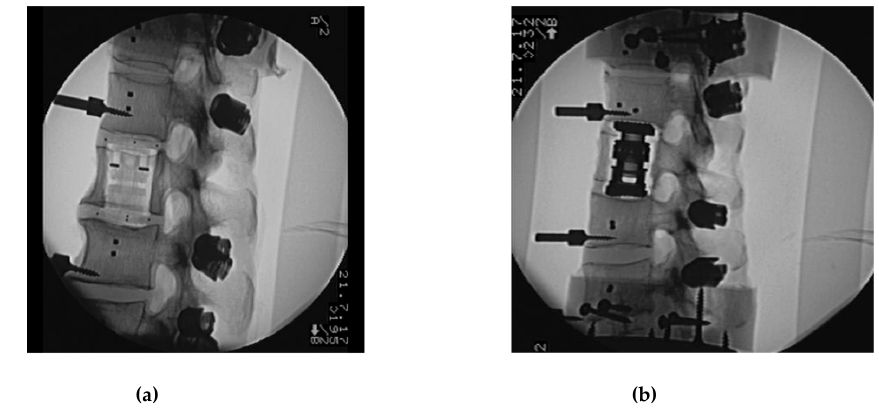
Figure 4. Lateral view native radiographs documenting correct positioning of the ( a ) prototype non-metallic, X-ray-translucent CF / PEEK expandable vertebral body replacement (VBR) and the expandable titanium VBR ( b